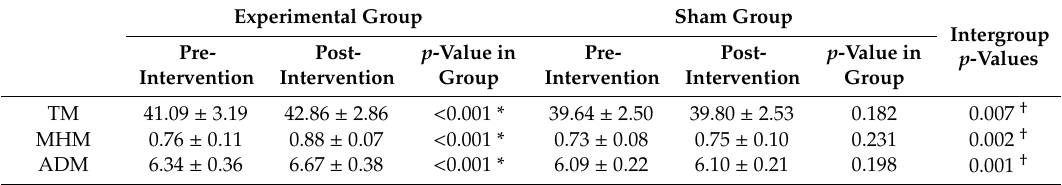
Figure 3. CONSORT diagram of participant recruitment. Table 2. Comparison of results between two group.